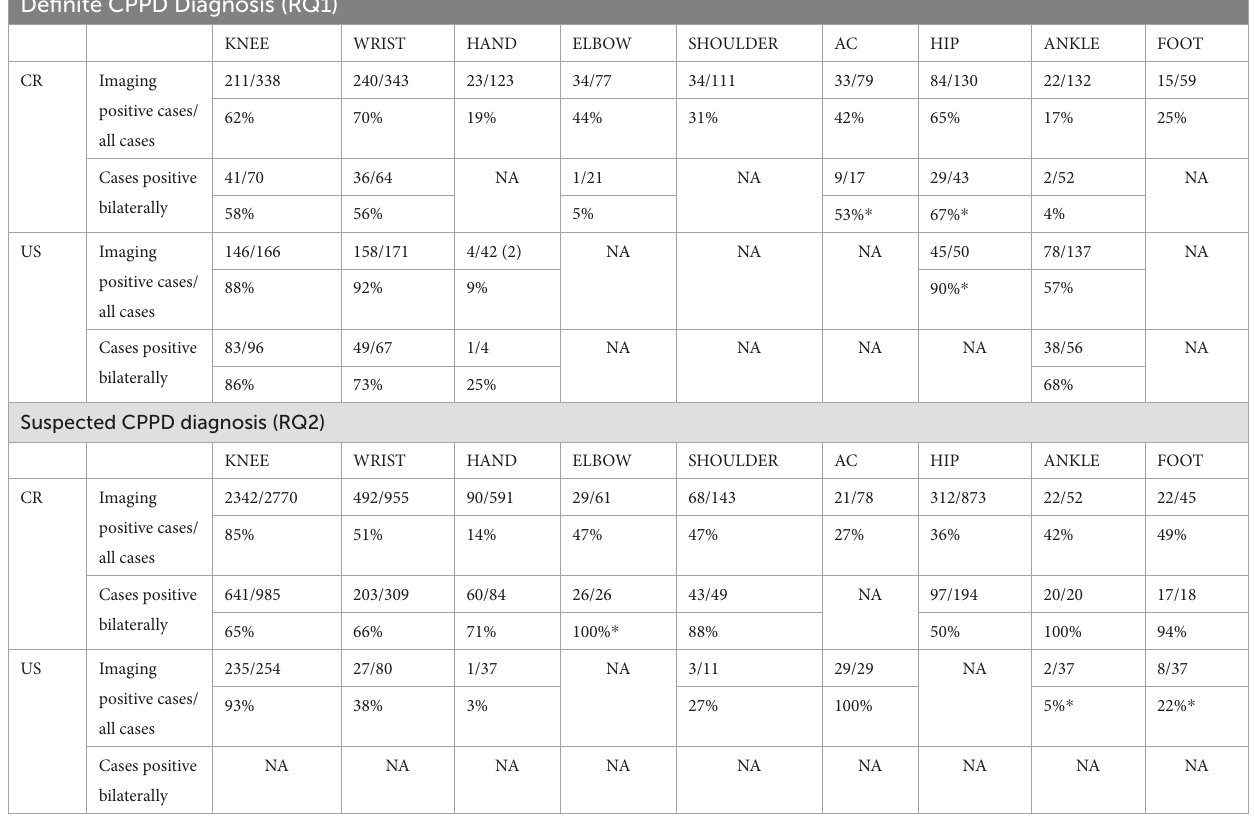
TABLE 2 Calcifications prevalence at level of each joint assessed: overall results. Definite CPPD Diagnosis